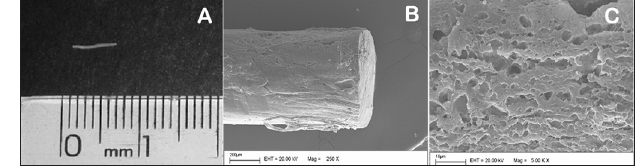
Figura 2. A: Visão macroscópica do implante biodegradável. B: Ima - gens de MEV do implante biodegradável com aumento de 250X. C: Imagens de MEV do implante biodegradável com aumento de 5000X.